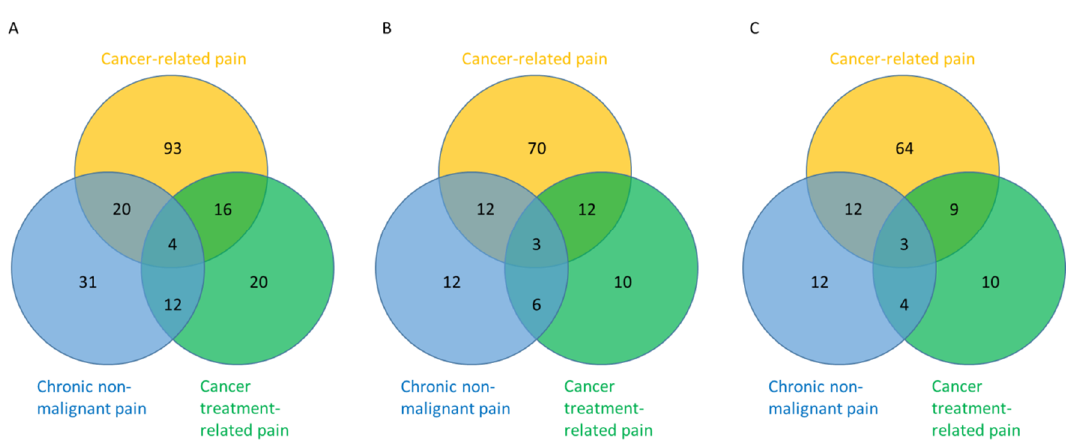
Figure 1. Distribution of pain diagnosis and opioid use. These Venn diagrams illustrate that cancer patients may present with one (non-overlapping) or multiple (overlapping) pain diagnoses at the same time and how opioids were being used. Cancer-related pain is shown in orange, cancer treatment-related pain is shown in green, and chronic non-malignant pain is shown in blue. ( A ) The numbers indicate the count of patients with corresponding pain diagnoses. As shown in the blue circle, a total of 67 (31 + 20 + 4 + 12) patients presented with chronic non-malignant pain, 31 had chronic non-malignant pain alone, and 36 presented with concurrent cancer-related pain and / or cancer treatment-related pain. ( B ) The numbers correspond to the count of patients within each category who were taking opioids (scheduled or rescue). For example, among all 67 patients with chronic non-malignant pain, 33 (12 + 12 + 3 + 6) were on opioids; 12 of 31 (39%) patients who had chronic non-malignant pain without other pain diagnoses were on opioids. ( C ) The use of rescue opioids for chronic non-malignant pain is examined here, with the numbers indicating the count of patients taking rescue opioids for each category. Among the 33 patients with chronic non-malignant pain who were on opioids, 31 (12 + 12 + 3 + 4) were taking them on an as needed basis. That means that only two patients with chronic non-malignant pain (and concurrent cancer treatment related pain) were prescribed scheduled opioid alone without rescue opioids for pain relief. 2.3. Clinical Characteristics associated with Chronic Non-Malignant Pain.